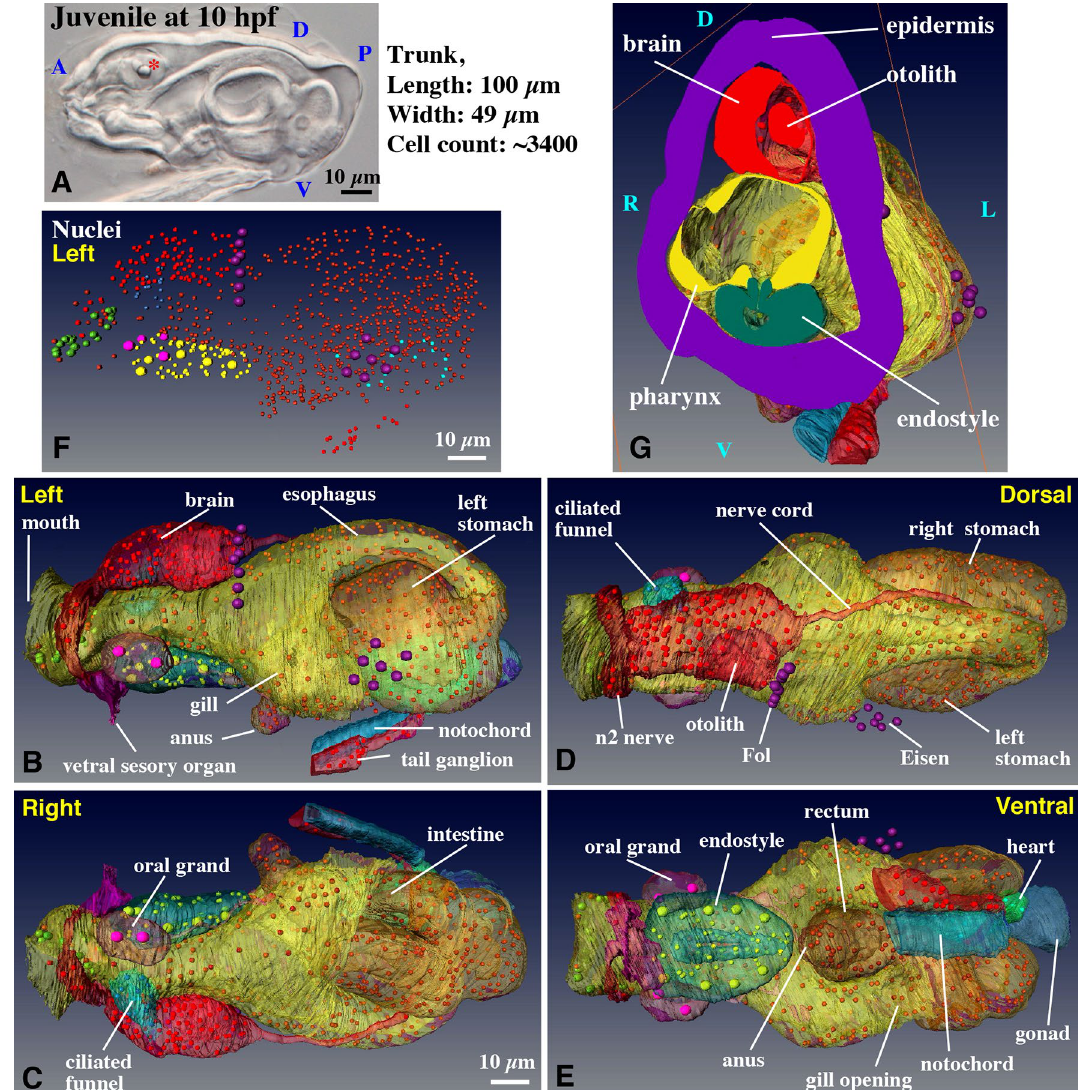
Figure 2. Structure and cellular organization of a young juvenile. Note that labeling order of photos in this panel is irregular. ( A ) A juvenile just after tail shift at 10 hpf. Most somatic cell divisions were completed by this stage, resulting in a body organization similar to that of adult animal. Organ formation was accomplished and the specimens started to feed. Otolith within the brain vesicle is indicated by asterisk. ( B – E ) 3D reconstruction of serial SBF-SEM sections. The full trunk and base of the tail are shown in the left, right, dorsal, and ventral views, respectively. The epidermis is removed. Only nuclei of giant Fol cells and giant Eisen cells on the left epidermis are shown, as positional landmarks. See Supplementary Movie 7 for the rotating 3D image. In ( E ), the heart (green) is covered by notochord and tail ganglion, thus most of the heart cannot be seen (see Fig. 4d and Supplementary Movie 13 for heart). The nuclei of the gonad in ( E ) is not shown (see Fig. 5 and Supplementary Movie 20 for gonad). ( F ) Positions of nuclei. The number of nuclei shown here counts 921 without gonad (31 nuclei). See Supplementary Movie 8 for the rotating 3D image. ( G ) Cross-section of the trunk showing the cavities of each organ and the thickness of the epithelia. Otolith within the sensory vesicle of the brain is visible on the dorsal side. See Supplementary Movie 9 for the entire series of transverse sections. ( B – G ) The images were generated using the Amira software package (ver. 5 and 6). A, anterior; P, posterior; D. dorsal; V, ventral; L, left; R, right. Scale bars, 10